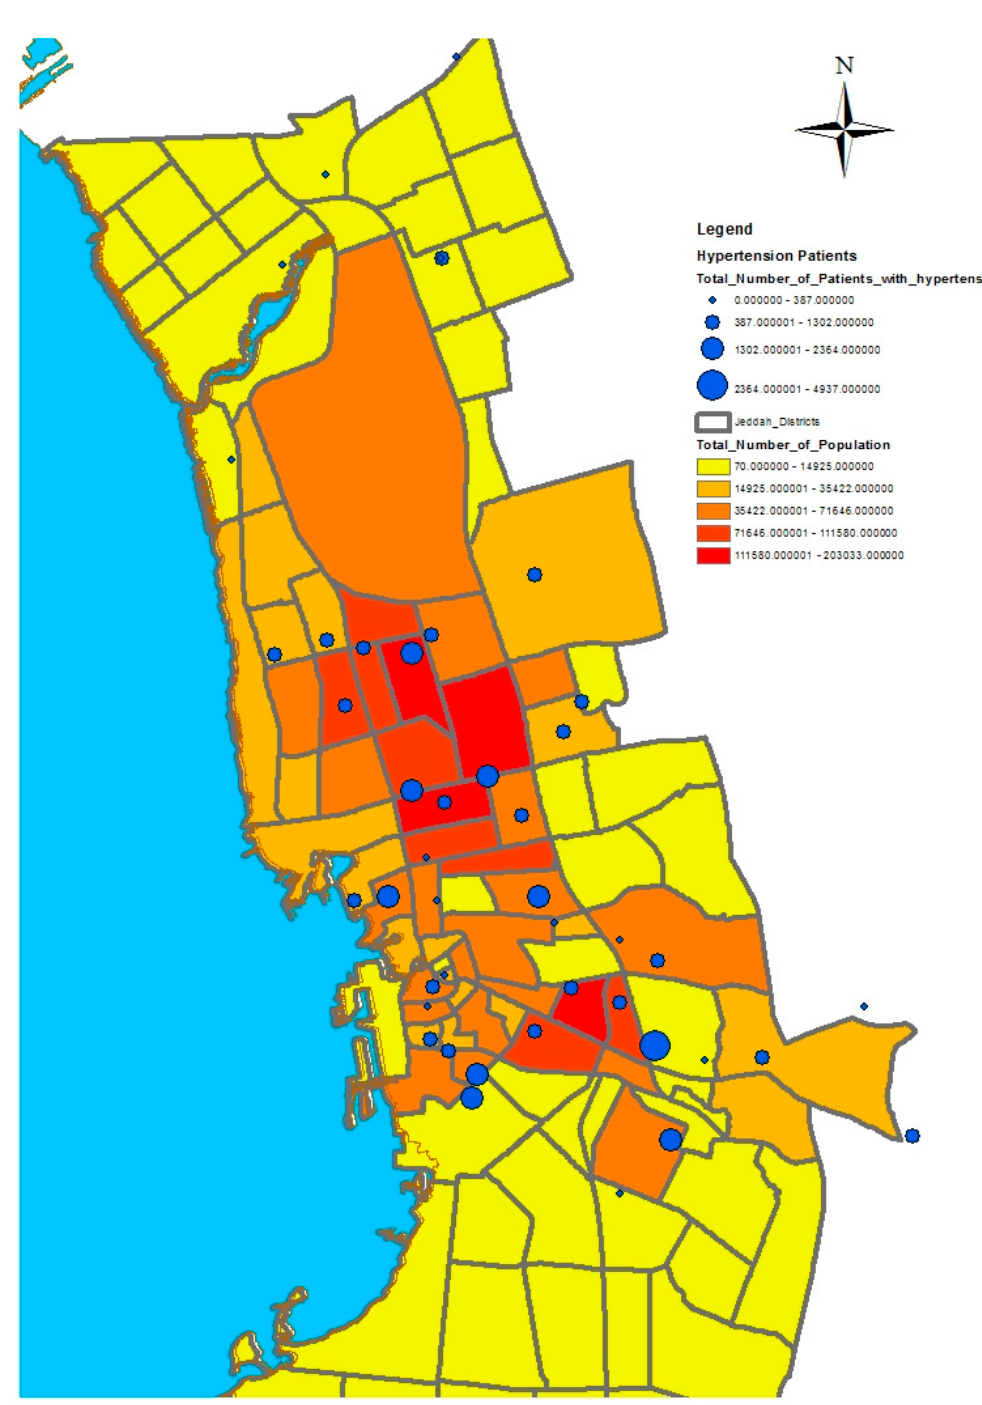
Figure 2. Spatial distribution of hypertension patients.